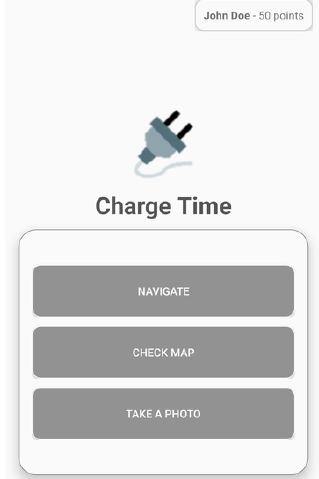
Figure 2. Charge Time application